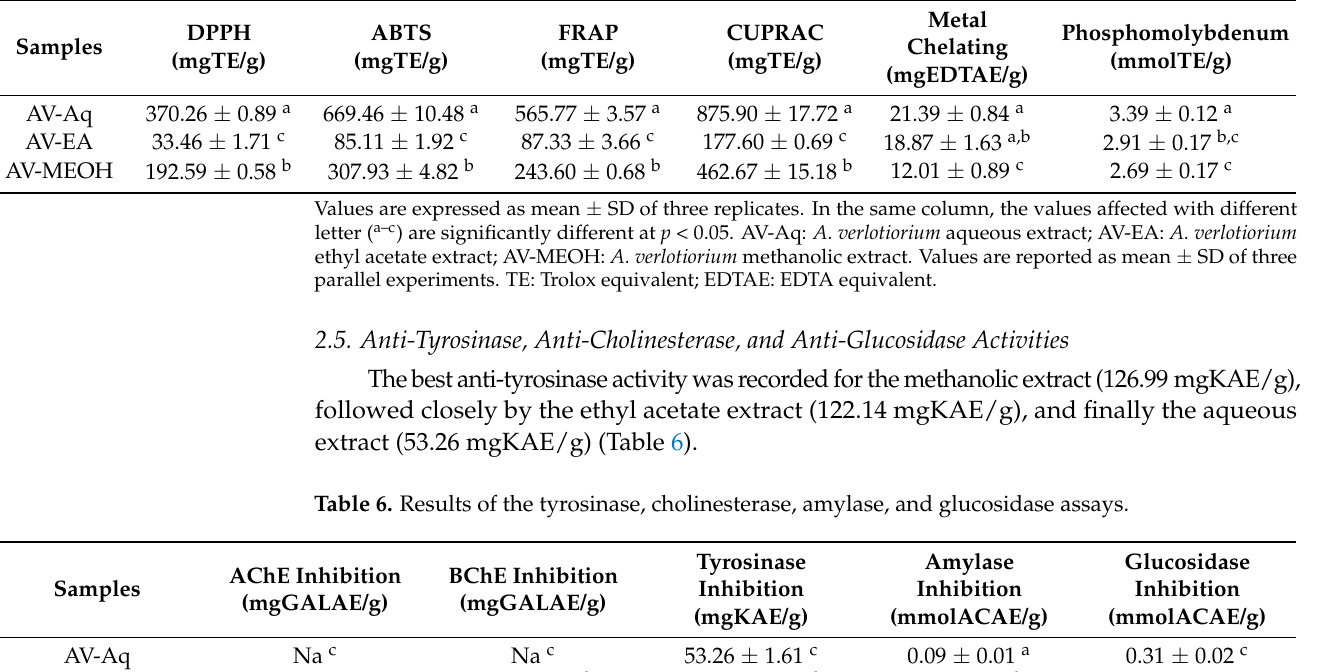
Table 5. Antioxidant activities of A. verlotiorum .